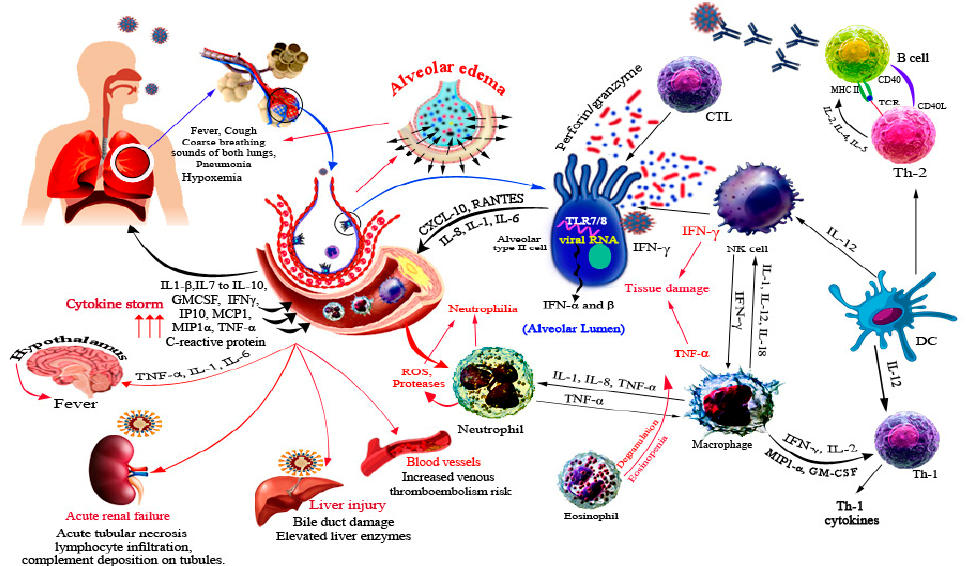
Figure 3. Immune response and immunopathogenesis associated with SARS-CoV-2. SARS-CoV-2 infects mainly type II alveolar cells and upon infection a wide array of cytokines and chemokines is secreted, which recruits several immune innate cells. Recruitment of cells further potentiates the immune response and usually results in tissue damage due to high concentration of IFN- γ and TNF- α . In addition, degranulation of eosinophils, proteases and ROS of neutrophils cause tissue damage. The participation of immune response in disease progression is illustrated by red arrows. SARS-CoV-2 is reported to cause systemic infections of liver, kidneys, and blood vessels.